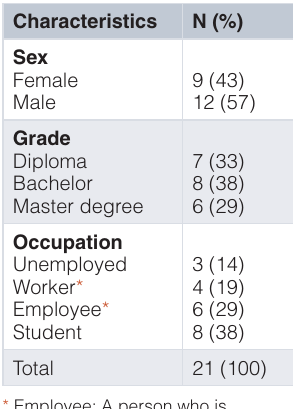
Table 1. Demographic characteristics of